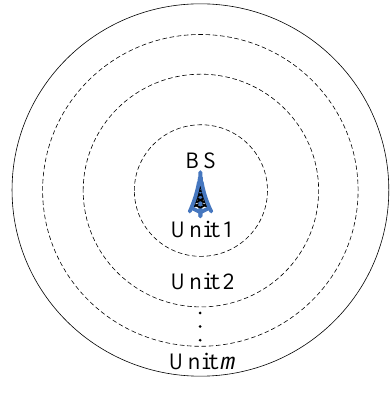
Figure 2. Network Figure 2. Network model.